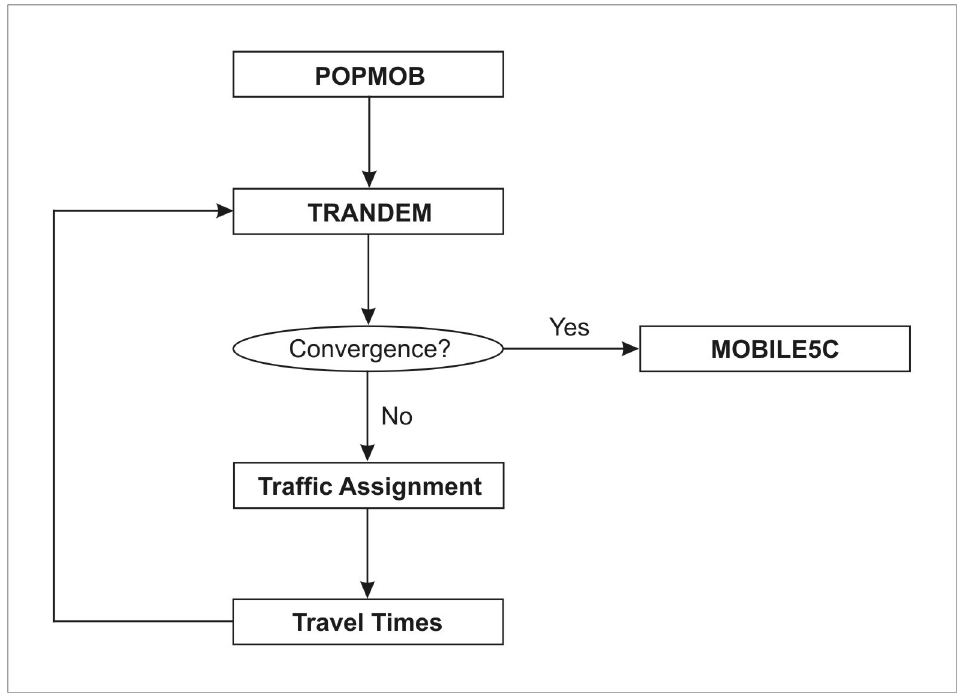
Figure 2. Basic structure of IMULATE.